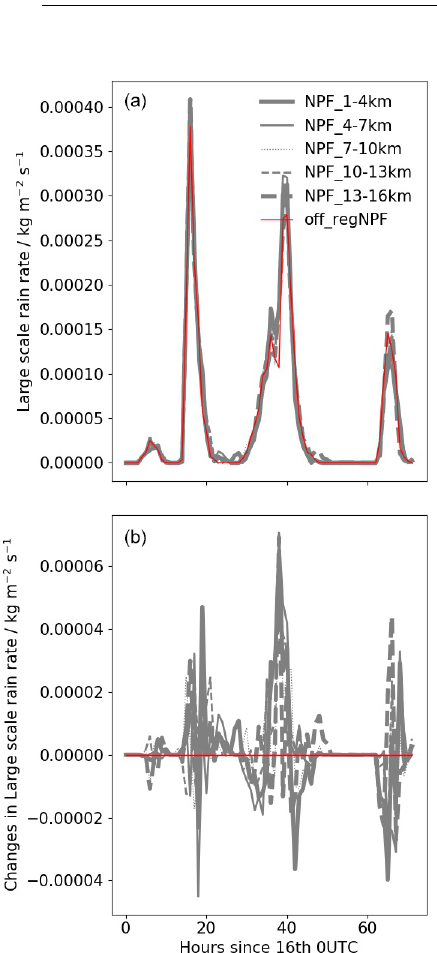
Figure A5. Regional domain-averaged time series of large-scale rain rate in simulations NPF_1-4km, NPF_4-7km, NPF_7-10km, NPF_10-13km, NPF_13-16km and off_regNPF (a) and the differ- ences between NPF switched on and off (NPF_Xkm − off_regNPF; b ).